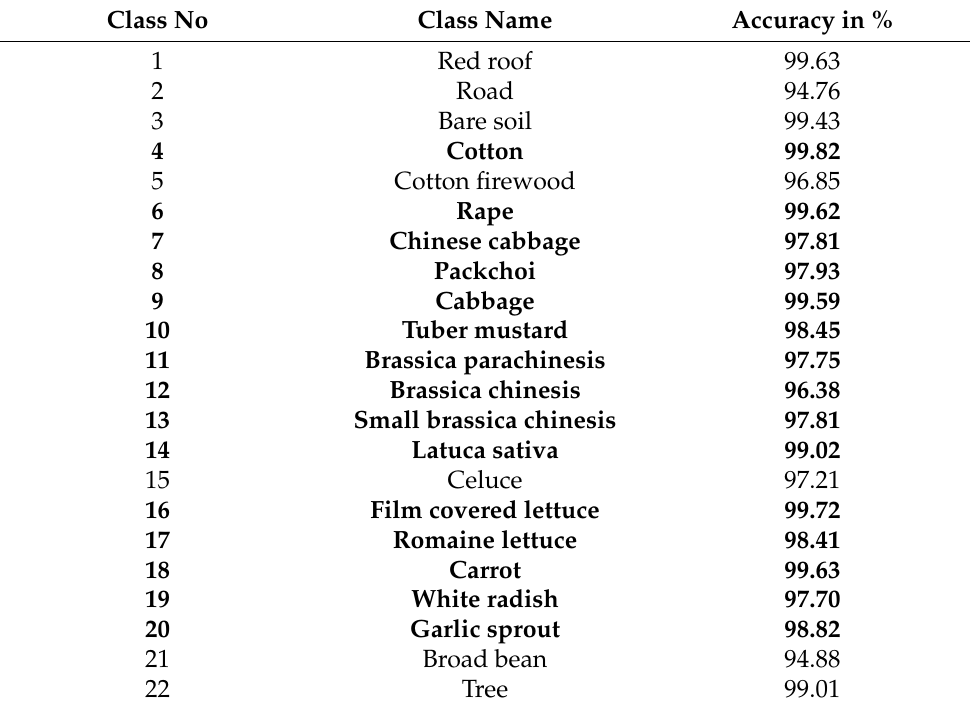
Table 8. Ablation experiments of the proposed